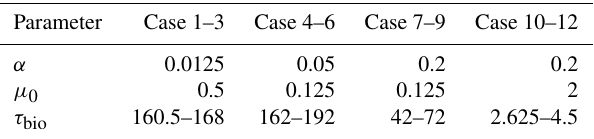
Table 1. Set of parameter values for 12 cases that compare best to WOA nitrate and CESM total phytoplankton. Each column repre- sents three cases with k N ∈ ( 0 . 25 , 1 , 4 ) . The range of τ bio covers those for all three k N